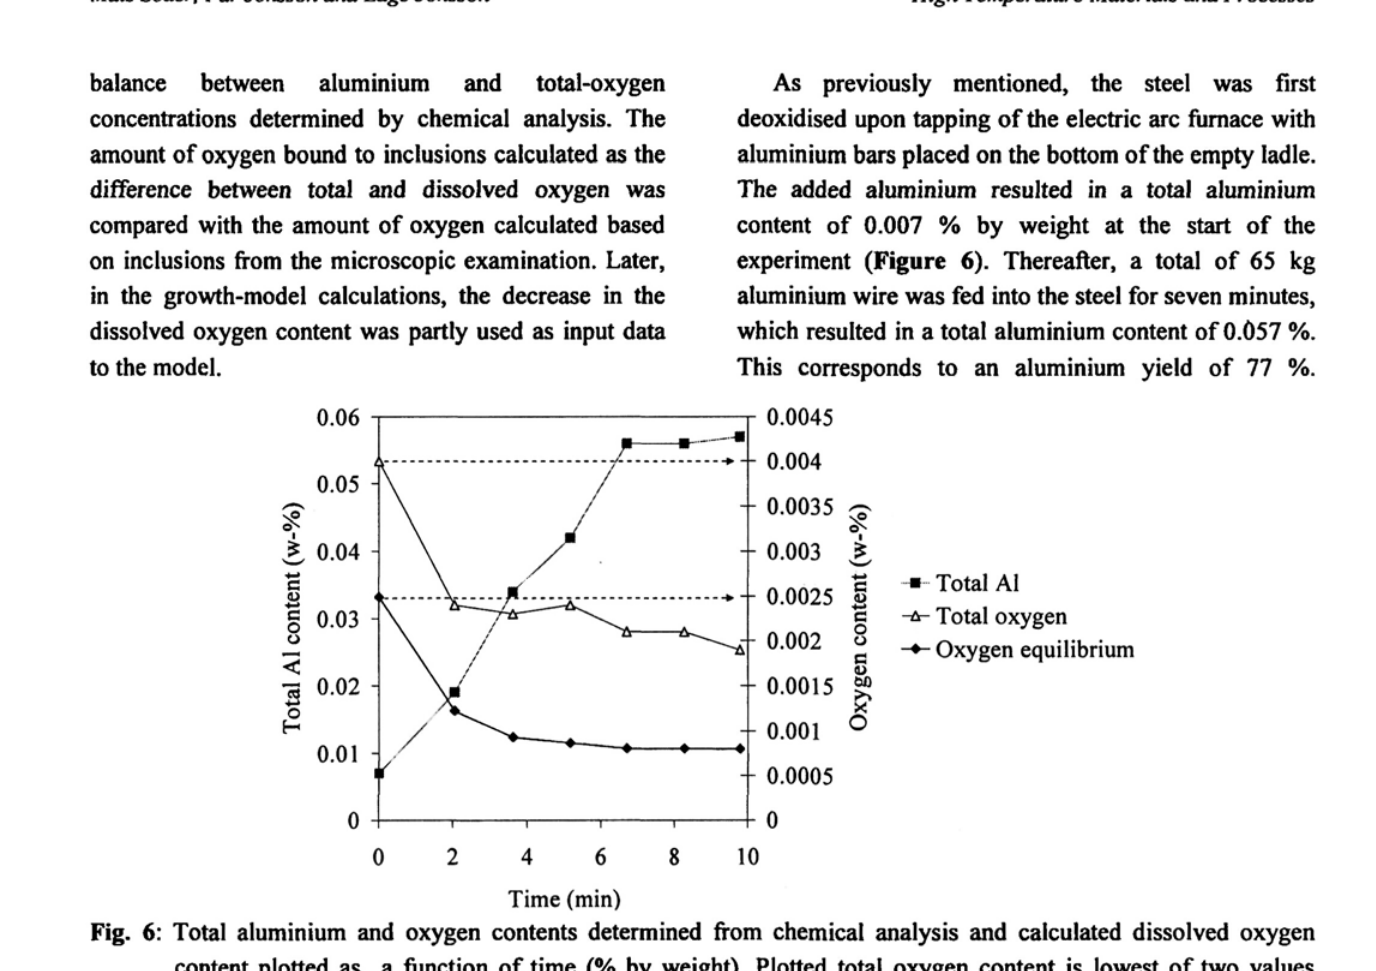
Fig. 6: Total aluminium and oxygen contents determined from chemical analysis and calculated dissolved oxygen content plotted as a function of time (% by weight). Plotted total oxygen content is lowest of two values determined from each